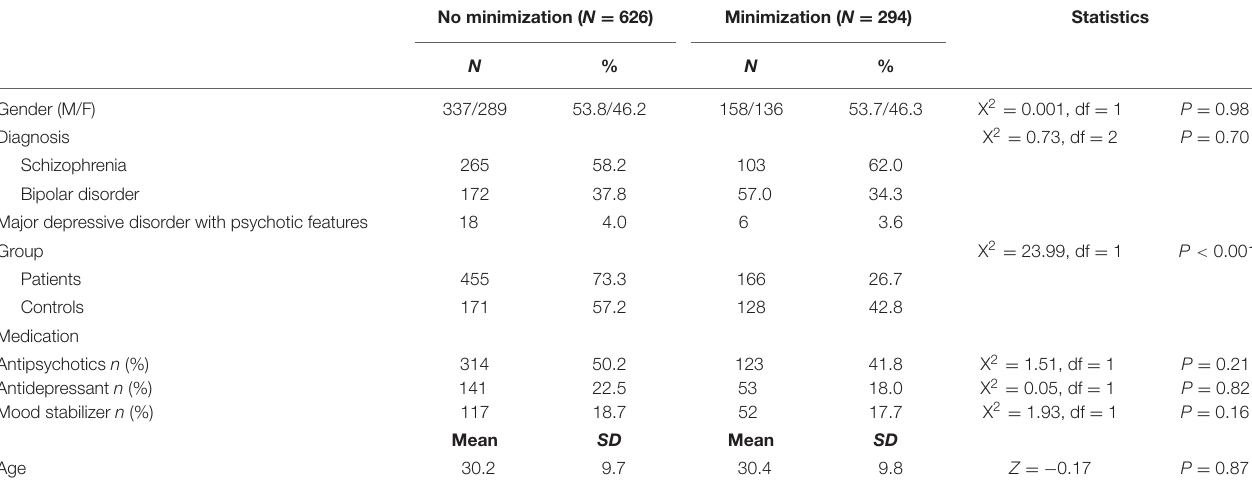
TABLE 1 | Demographics of the sample divided into presence of